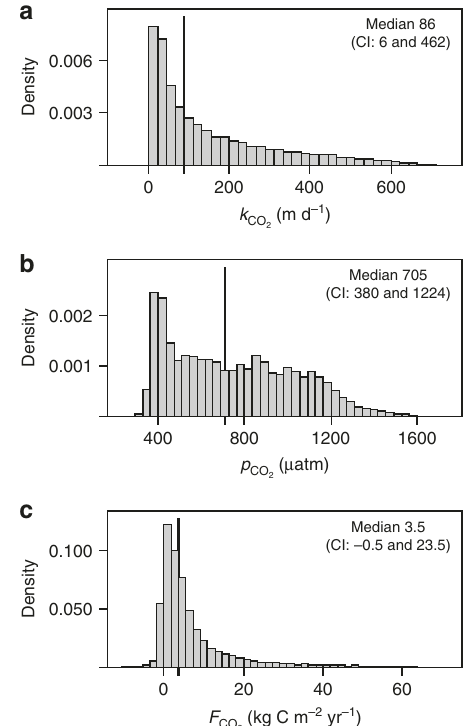
Fig. 1 Patterns of CO 2 in streams in the Swiss Alps. The distributions of k ( a ), p CO 2 ( b ) and areal CO 2 fl uxes ( F